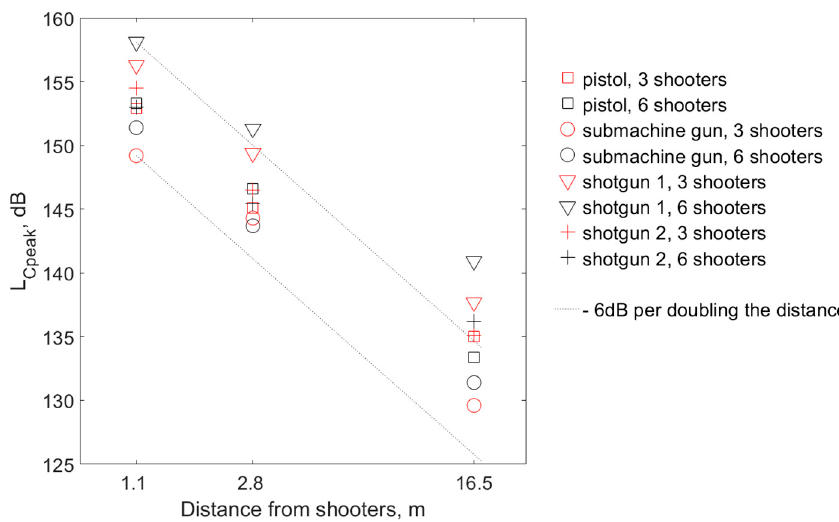
Figure 5. C-weighted peak SPL measured at the shooting instructor’s locations, representative of one shooting cycle for both variants of the number of shooters (three or six) simultaneously firing with three different distances between the shooting instructor and the shooters. The values were determined as a result of averaging all data obtained during the tests at the shooting range under the determined conditions. A logarithmic (base 10) scale is used for the X-axis. Dotted line—a line with a slope of − 6 dB per doubling the distance.